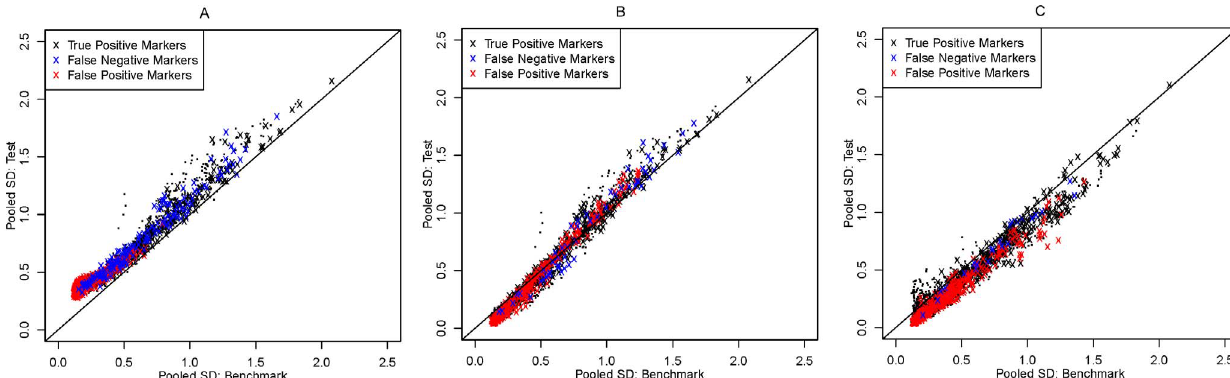
Figure 3. Scatter plot comparing pooled standard deviations in the benchmark data and that in the test data for (A) no normalization, (B) median normalization, and (C) quantile normalization. Black ‘‘x’’: true positive markers. Red ‘‘x’’: false positive markers. Blue ‘‘x’’: false negative markers. Black dots: true negative markers.